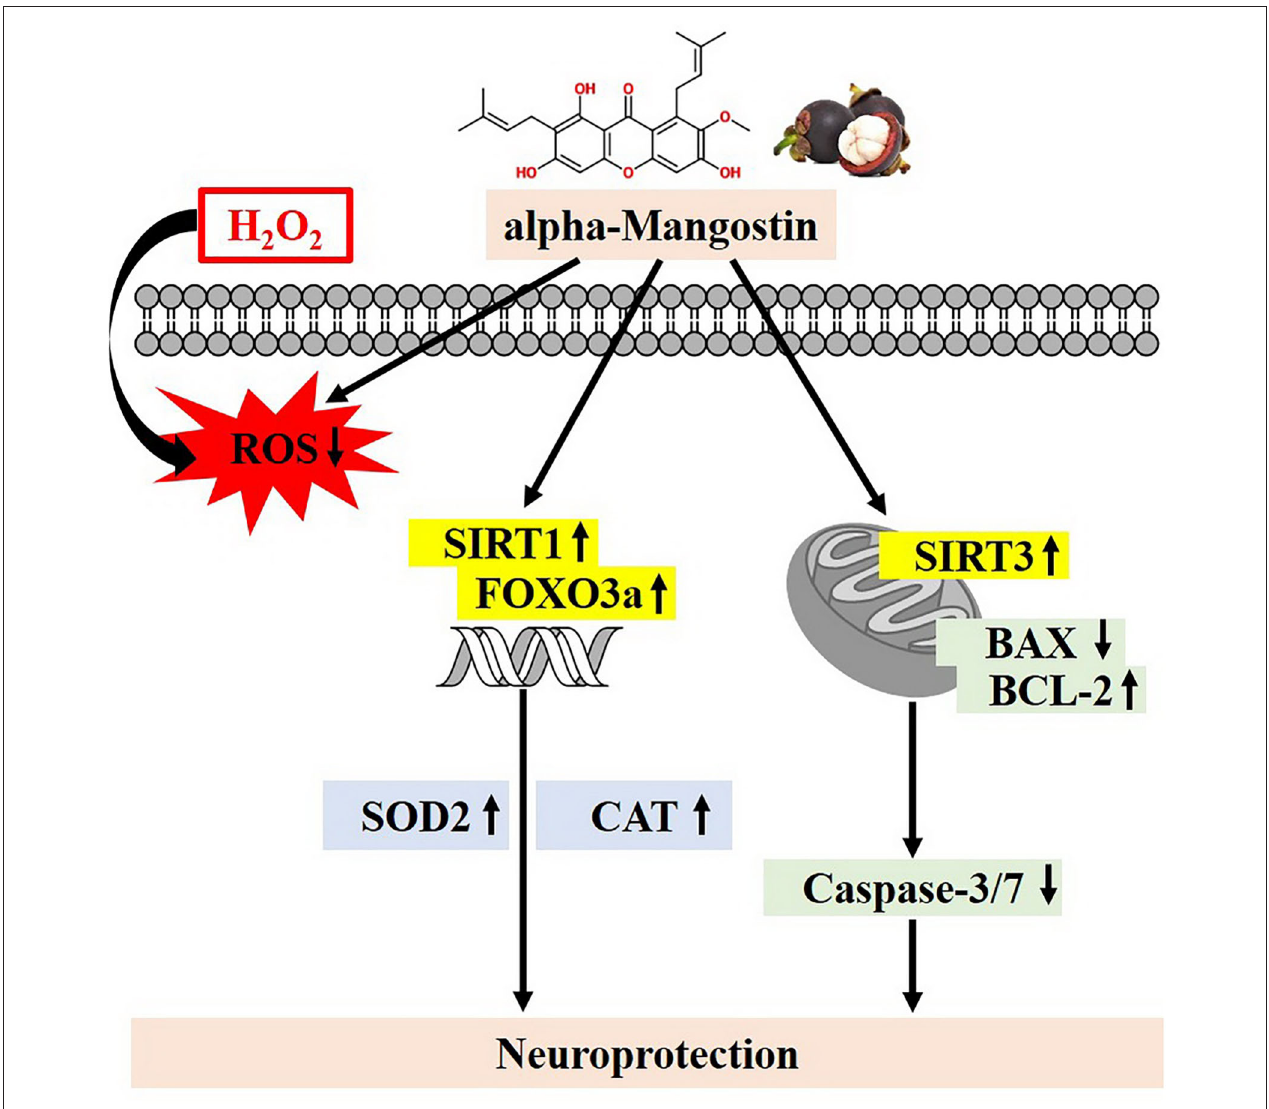
FIGURE 7 | Proposed schematic neuroprotective mechanisms of alpha-mangostin under oxidative damage. alpha-Mangostin attenuates H 2 O 2 -induced apoptosis and oxidative stress in SH-SY5Y neuroblastoma cells via the activation of SIRT1/3-FOXO3a signaling pathway.